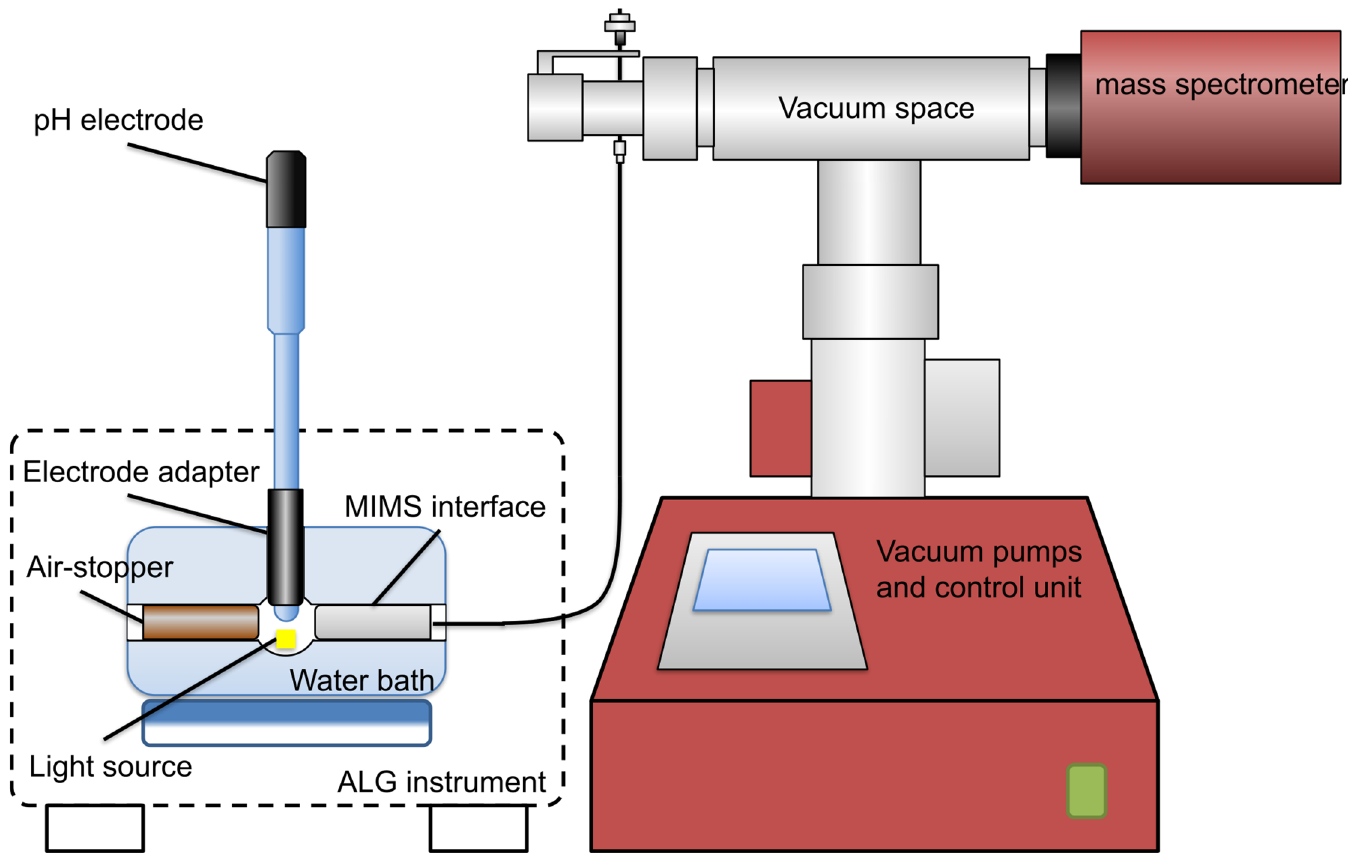
Fig 2. Integration of pHOS and MIMS system with the ALG instruments. The dashed line shows the size and shape of an ALG instruments bioreactor control unit in the background.